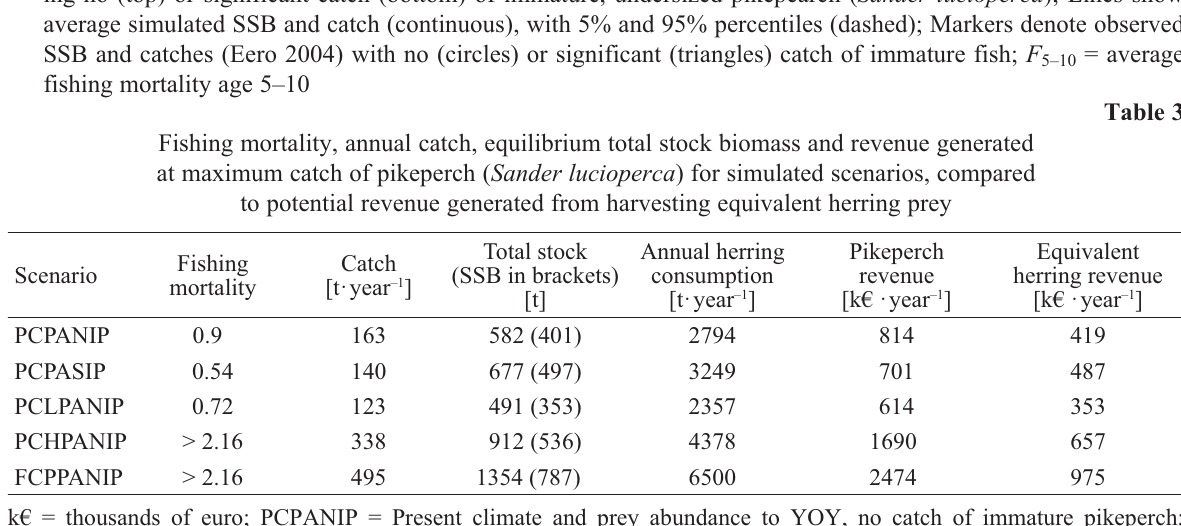
k€ = thousands of euro; PCPANIP = Present climate and prey abundance to YOY, no catch of immature pikeperch; PCPASIP = Present climate and prey abundance to YOY, significant catch of immature fish; PCLPANIP =Present climate, low prey abundance to YOY, no catch of immature pikeperch; PCHPANIP =Present climate, high prey abundance to YOY, no catch of immature pikeperch; FCPPANIP = “Future” climate, present prey abundance to YOY, no catch of immature pikeperch. SSB = spawning stock